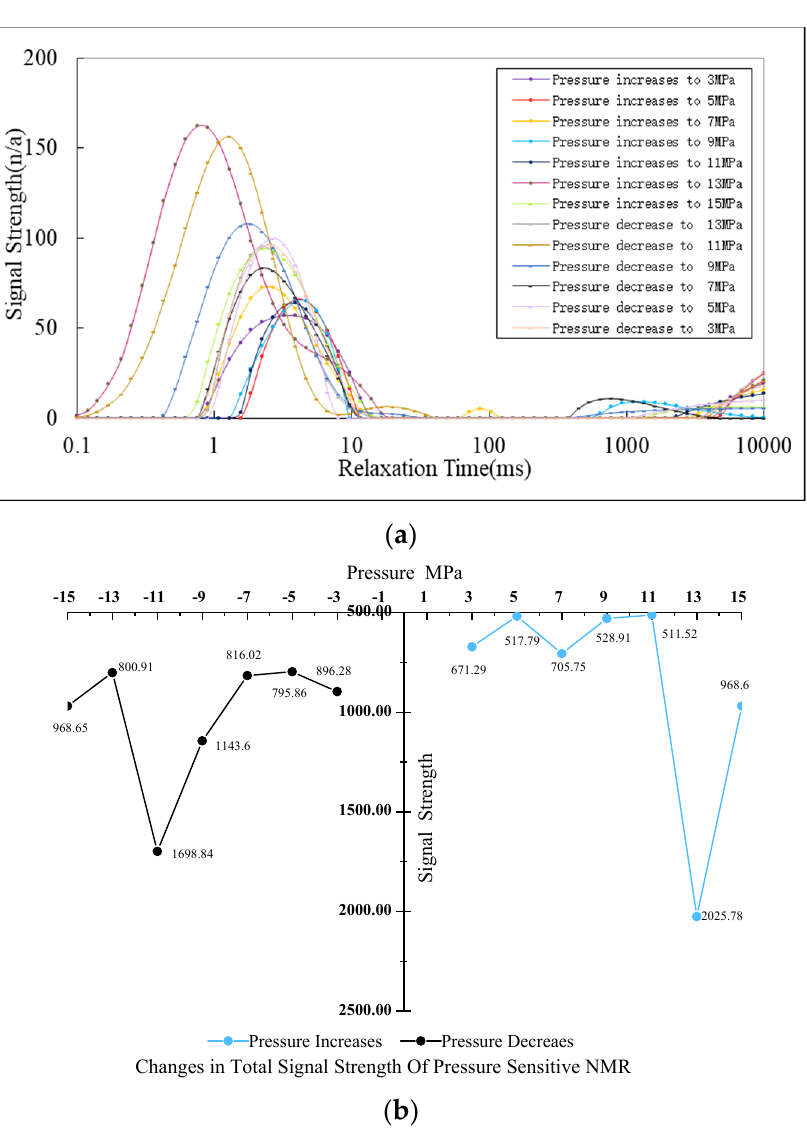
Figure 20. Typical radial compression NMR test spectrum. ( a ) NMR T2 spectrum, ( b ) curve of total core signal value versus radial pressure.